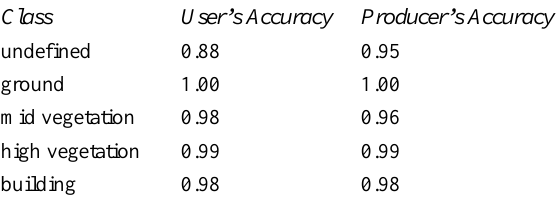
Table 3. User’s and Producer’s accuracy of the automatic geometrical